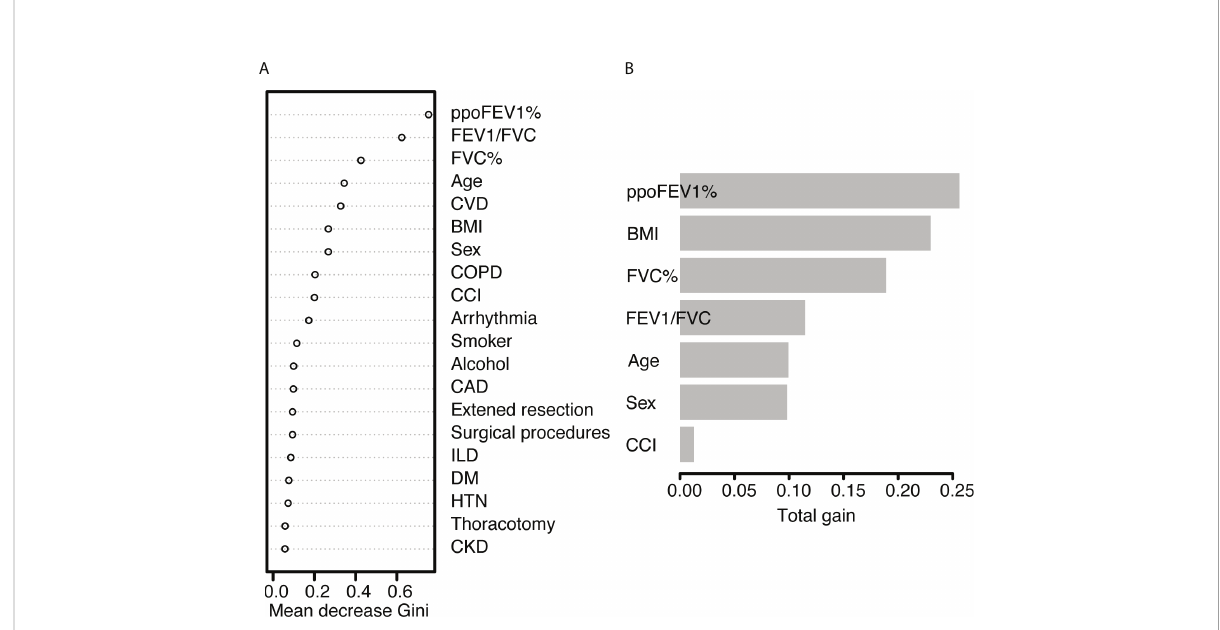
FIGURE 4 The feature importance of (A) the random forest model and (B) the XGBoost model. PpoFEV1%, the percentage of predicted postoperative forced expiratory volume in one second; FEV1/FVC, the ratio of forced expiratory volume in one second to forced vital capacity; FVC%, the percentage of forced vital capacity; CVD, cerebrovascular disease; BMI, body mass index; COPD, chronic obstructive pulmonary disease; CCI, the Charlson Comorbidity Index; CAD, coronary artery disease; ILD, Interstitial lung disease; DM, diabetes mellitus; HTN, hypertension; CKD, chronic kidney disease.